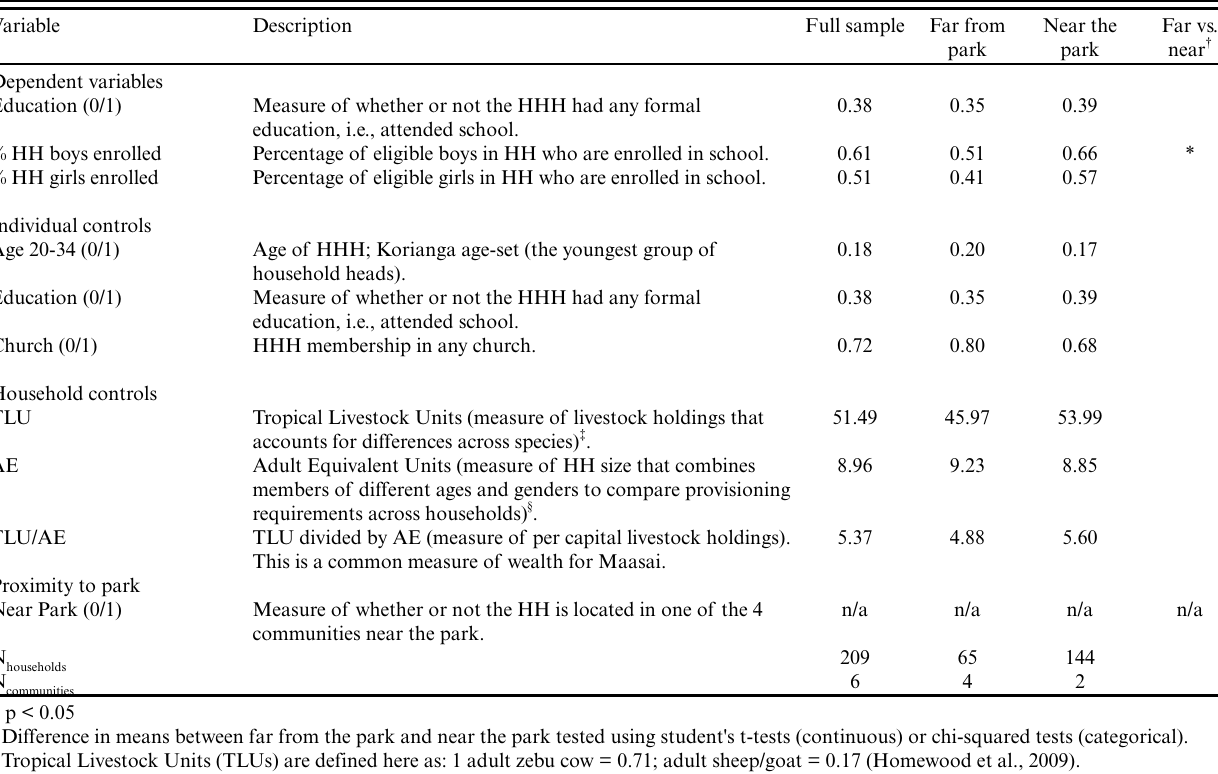
Table 2 . Descriptions of variables used in regression analyses. Variable Description Full sample Far from